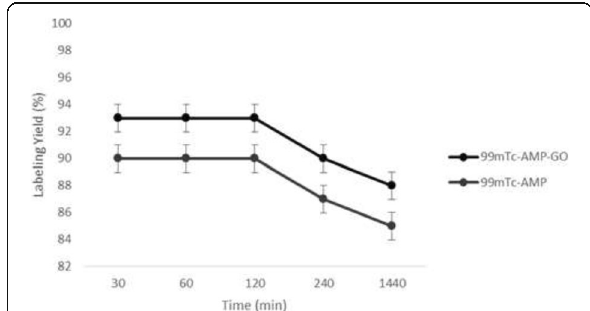
Fig. 1 (abstract PP31). The in vitro stability of 99m Tc-AMP and 99m Tc-AMP-GO at various times after incubation in phosphate buffered saline at room temperature. Data are presented as mean ± standard deviation